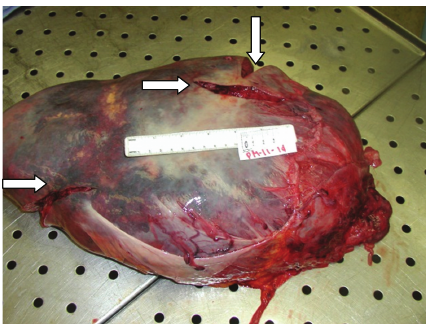
Figure 1: Gross specimen of a massive spleen weighing 6400 grams Note the multiple capsular lacerations present (arrows).